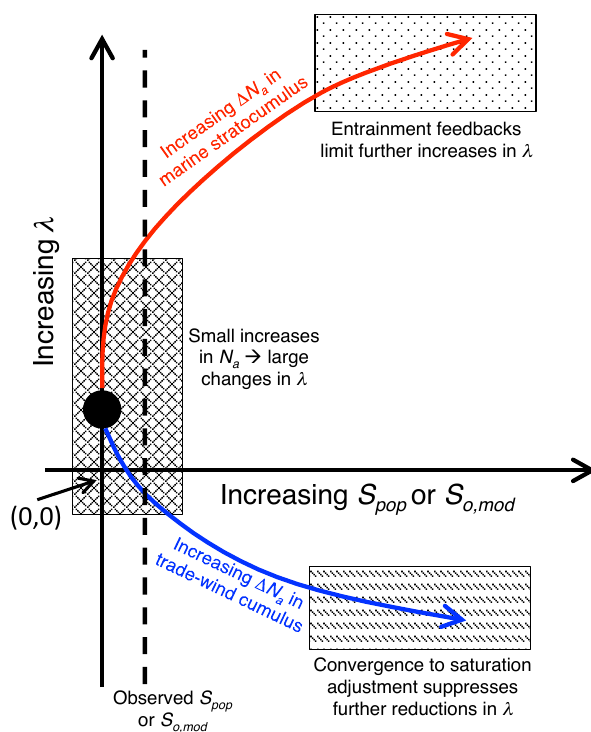
Figure 9. Schematic representation of the results presented herein. The curves correspond to the trajectories in the λ – S pop parameter space for increasing changes in N a (i.e., 1N a ) in marine stratocu- mulus (red) and trade wind cumulus (blue). The highlighted regions of the parameter space include areas where further increases in S pop result in smaller changes in λ due to entrainment effects (dotted), where cloud microphysical characteristics asymptote to nearly con- stant values for larger 1N a (dashed), and where λ changes rapidly relative to small changes in S pop